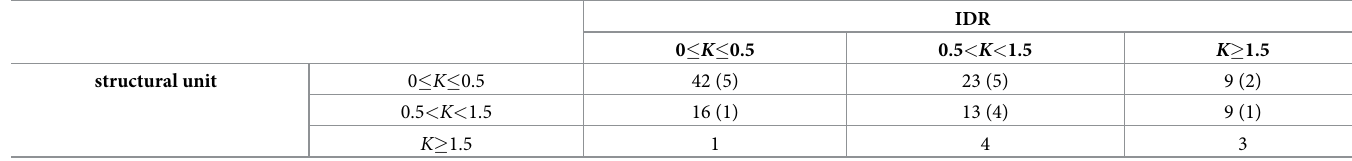
Table 1. The segmentation of the analyzed proteins according to the values of parameter K (divided into 3 ranges) of IDR and structural unit: The number of pro- teins in each of 9 groups is presented (in parentheses—the number of proteins with disulfide